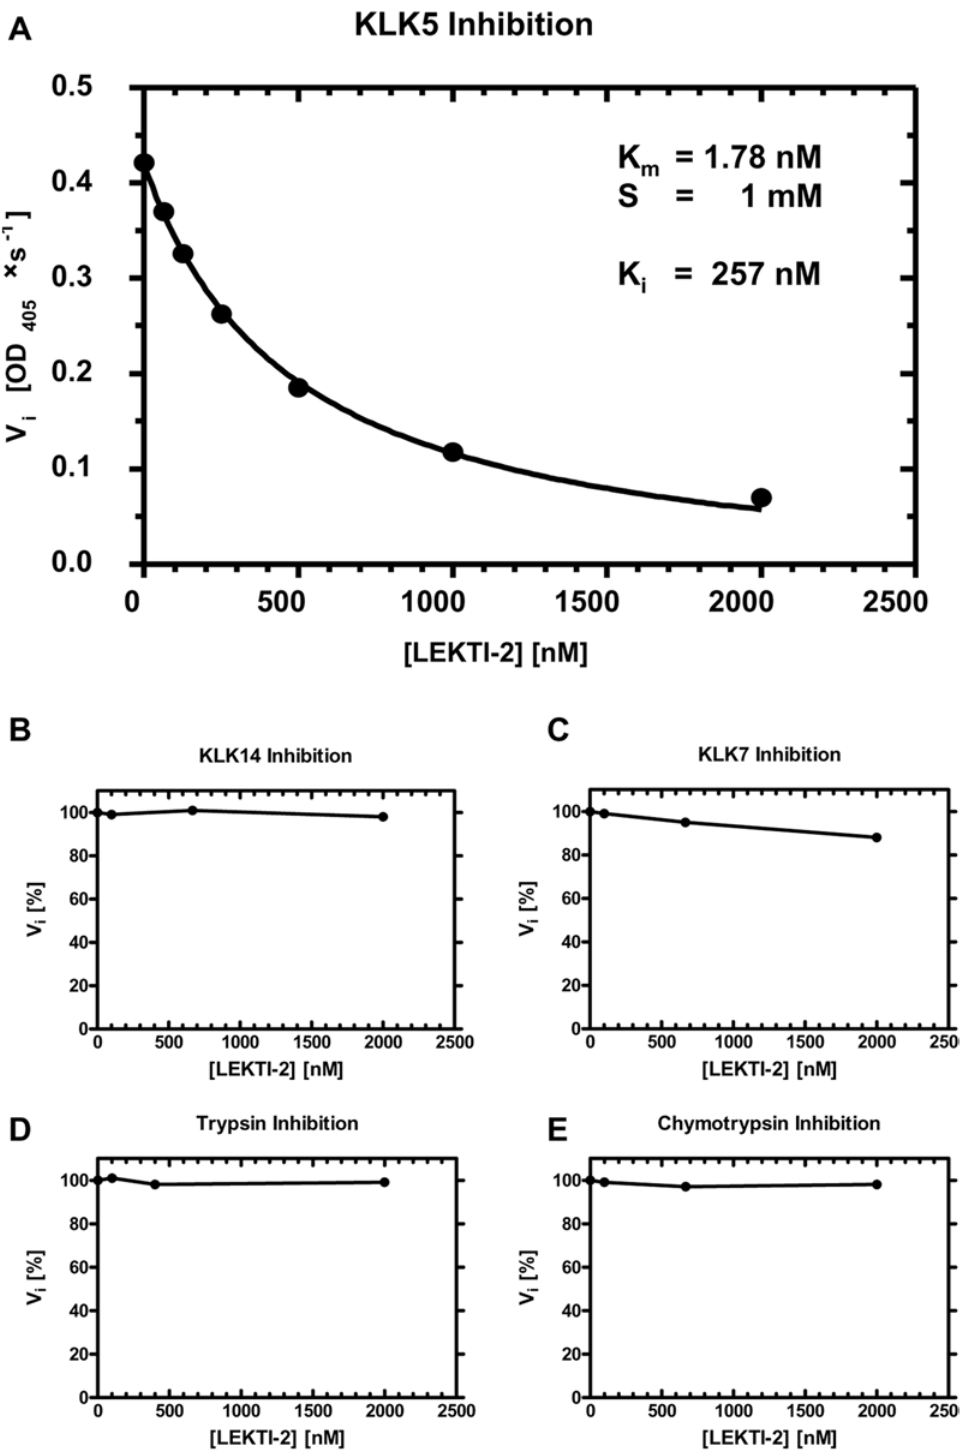
Figure 6. Inhibition of KLK5 by rLEKTI-2. (A) Enzyme kinetic of KLK5 (5 nM) and LEKTI-2 (0 to 2000 nM) in comparison to no inhibition of KLK14 (B), KLK7 (C), trypsin (D) and chymotrypsin (E). The substrate for KLK5 was MeO-Suc-Arg-Pro-Tyr-pNA (1 mM). Points represent mean of triplicate experiments and the solid line represents the fitted curve according to equation of Baici model [33]. doi:10.1371/journal.pone.0004372.g006 Specific concentrations of protease, substrate and inhibitor are indicated in Table 1. The changes of absorbance at 405 nm were followed up to 16 h in comparison with enzyme-free controls.